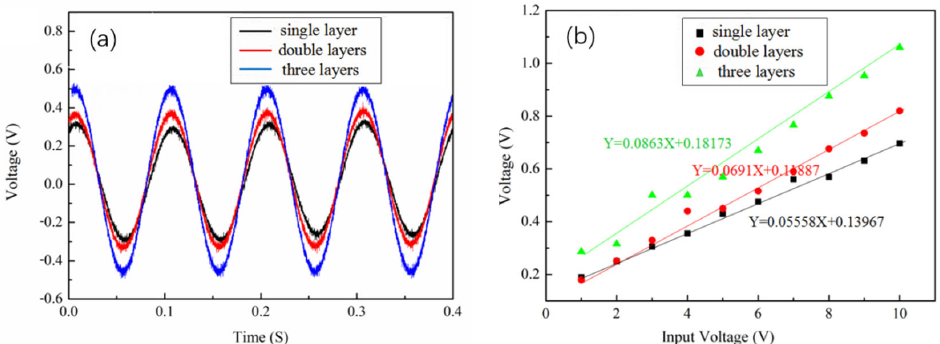
Figure 9. ( a ) Output voltage of multi-layer film sensors and ( b ) relationship between output and input voltages of multi-layer film